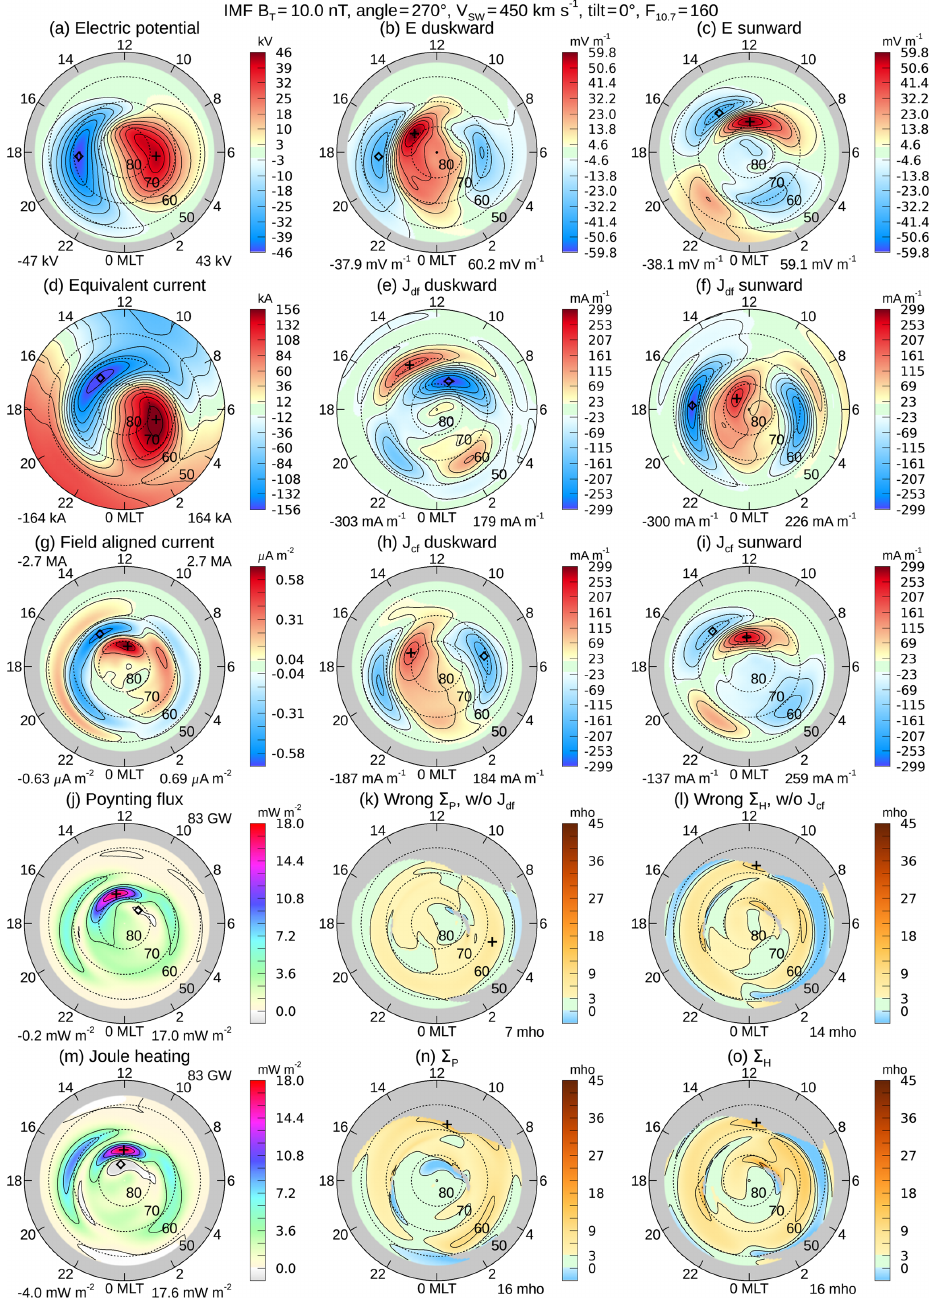
Figure 5. Conductivity input data and results for the same conditions as in Fig. 1, except that IMF clock angle is changed 270 ◦ . The IMF B T magnitude is 10nT, the solar wind velocity is 450km s − 1 , the F 10 . 7 index is 160sfu, and the dipole tilt angle is 0 ◦ .